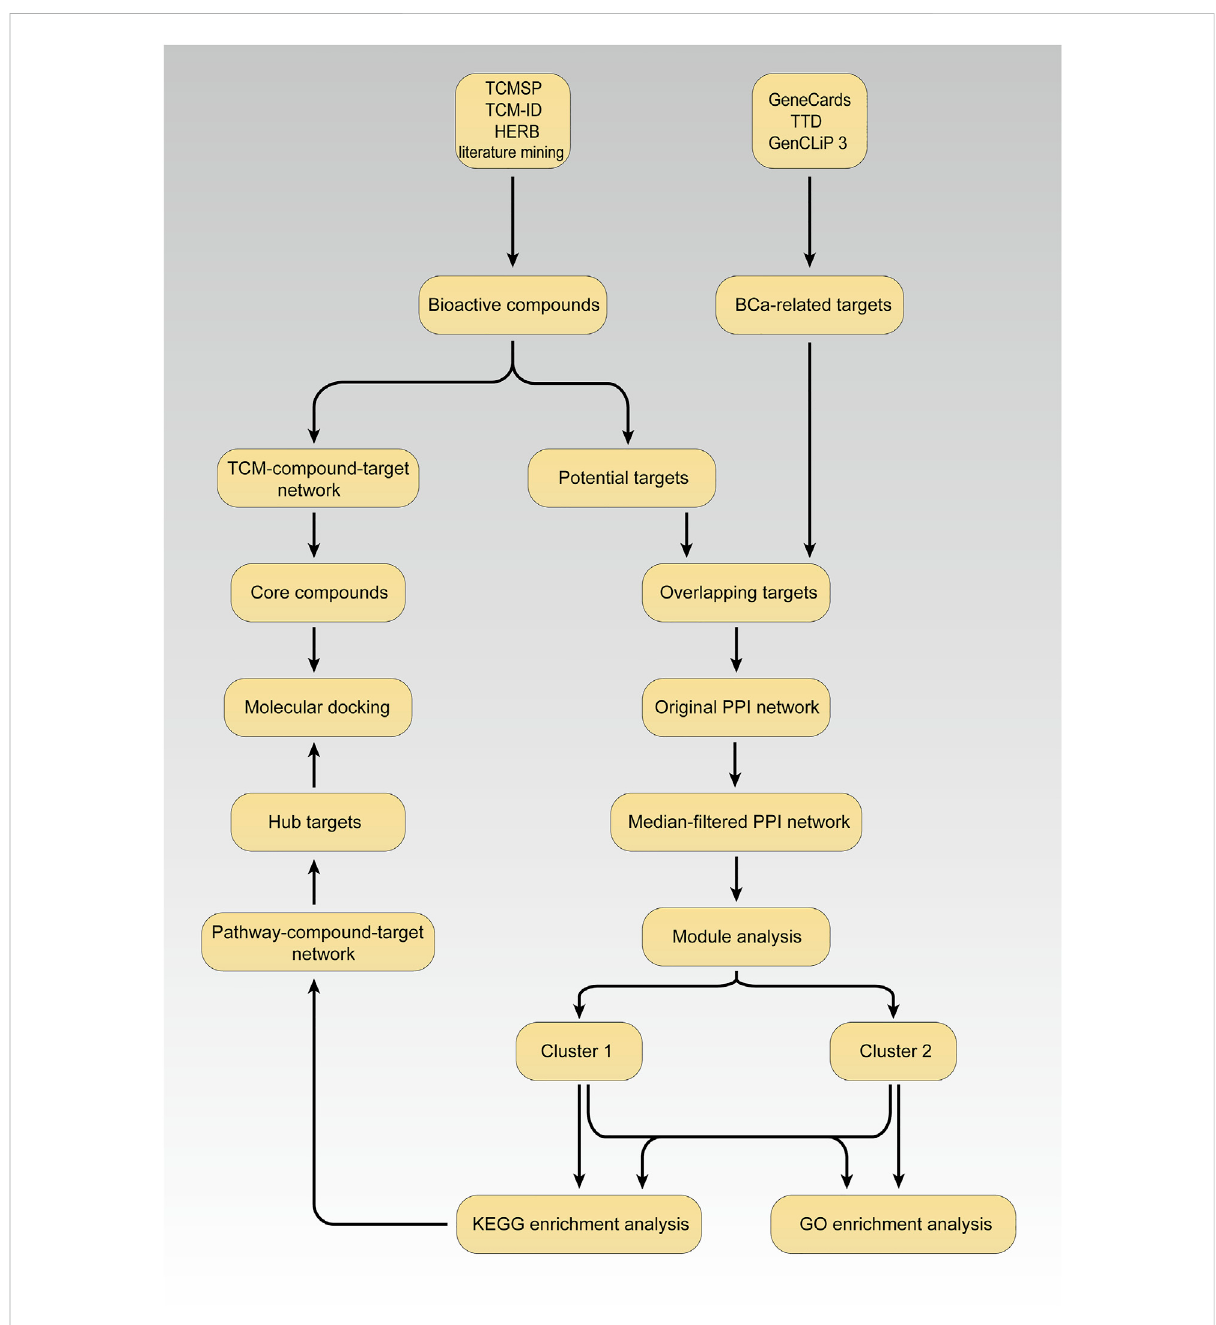
FIGURE 1 The scheme for investigation of mechanisms of LSYQ Decoction on the treatment of